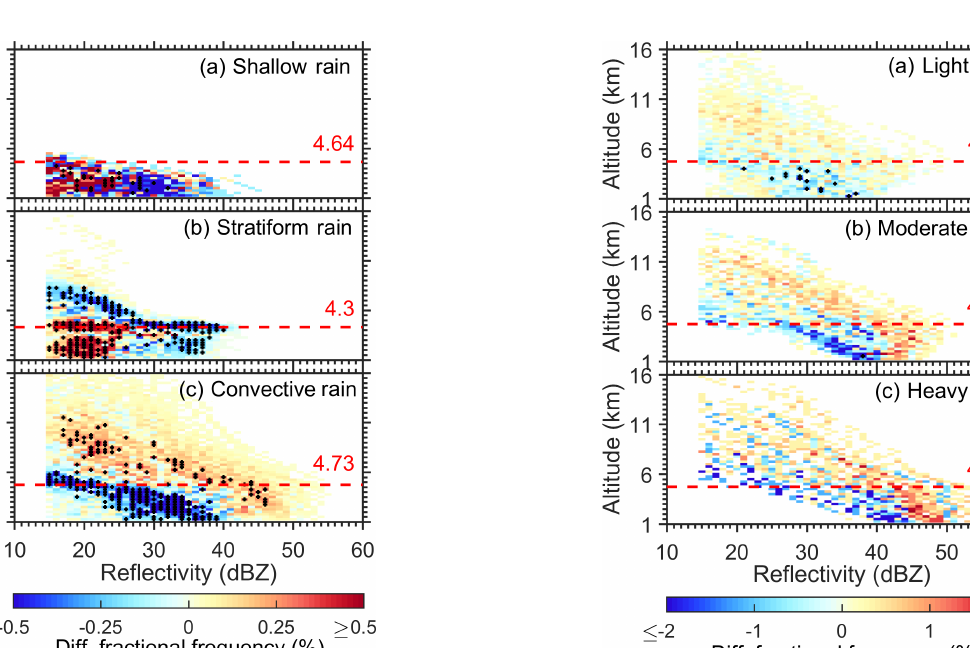
Figure 4. Joint occurrence frequency of PM 10 – Z pair for (a) shallow, (b) stratiform, and (c) convective rain regimes, respectively. Z is acquired from TRMM 2A23 products for altitudes ranging from 1 to 5km during the period 2007–2012. The top 1% (mean) with respect to occurrence frequency for each PM 10 concentration bin is represented by dashed (solid) black lines. The total number of Z values ( N ) used for the calculation of frequency is shown in the upper-right corner of each panel.